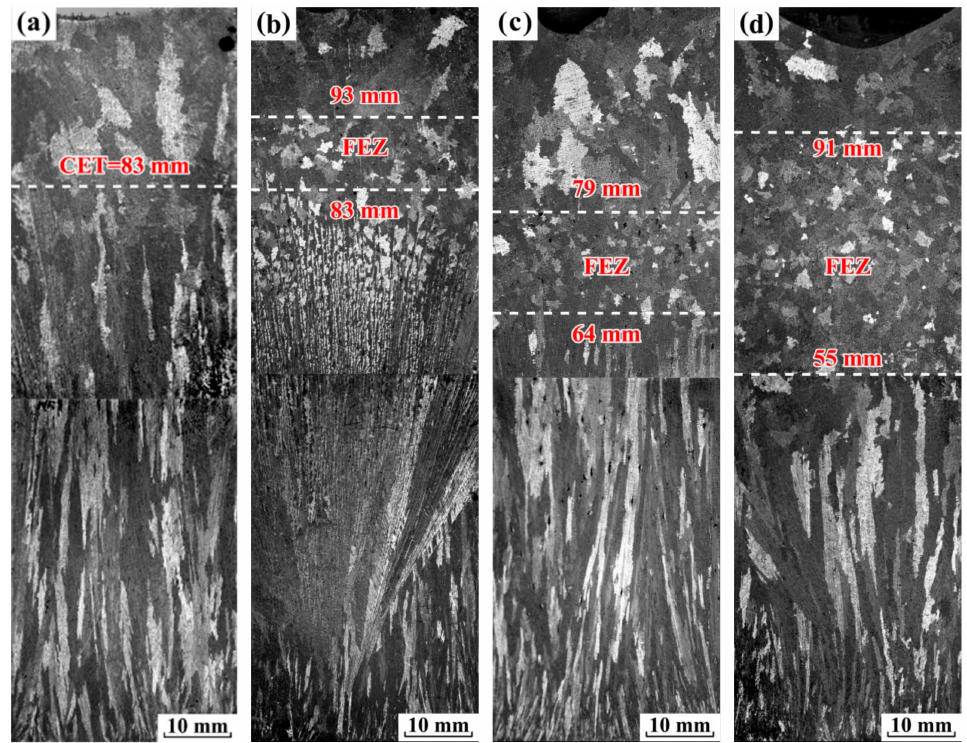
Figure 4. The as-cast macrostructure on the longitudinal section of Al-7Si alloy: ( a ) Without AECP; ( b ) under AECP with 300 A; ( c ) under AECP with 400 A; ( d ) under AECP with 600 A.